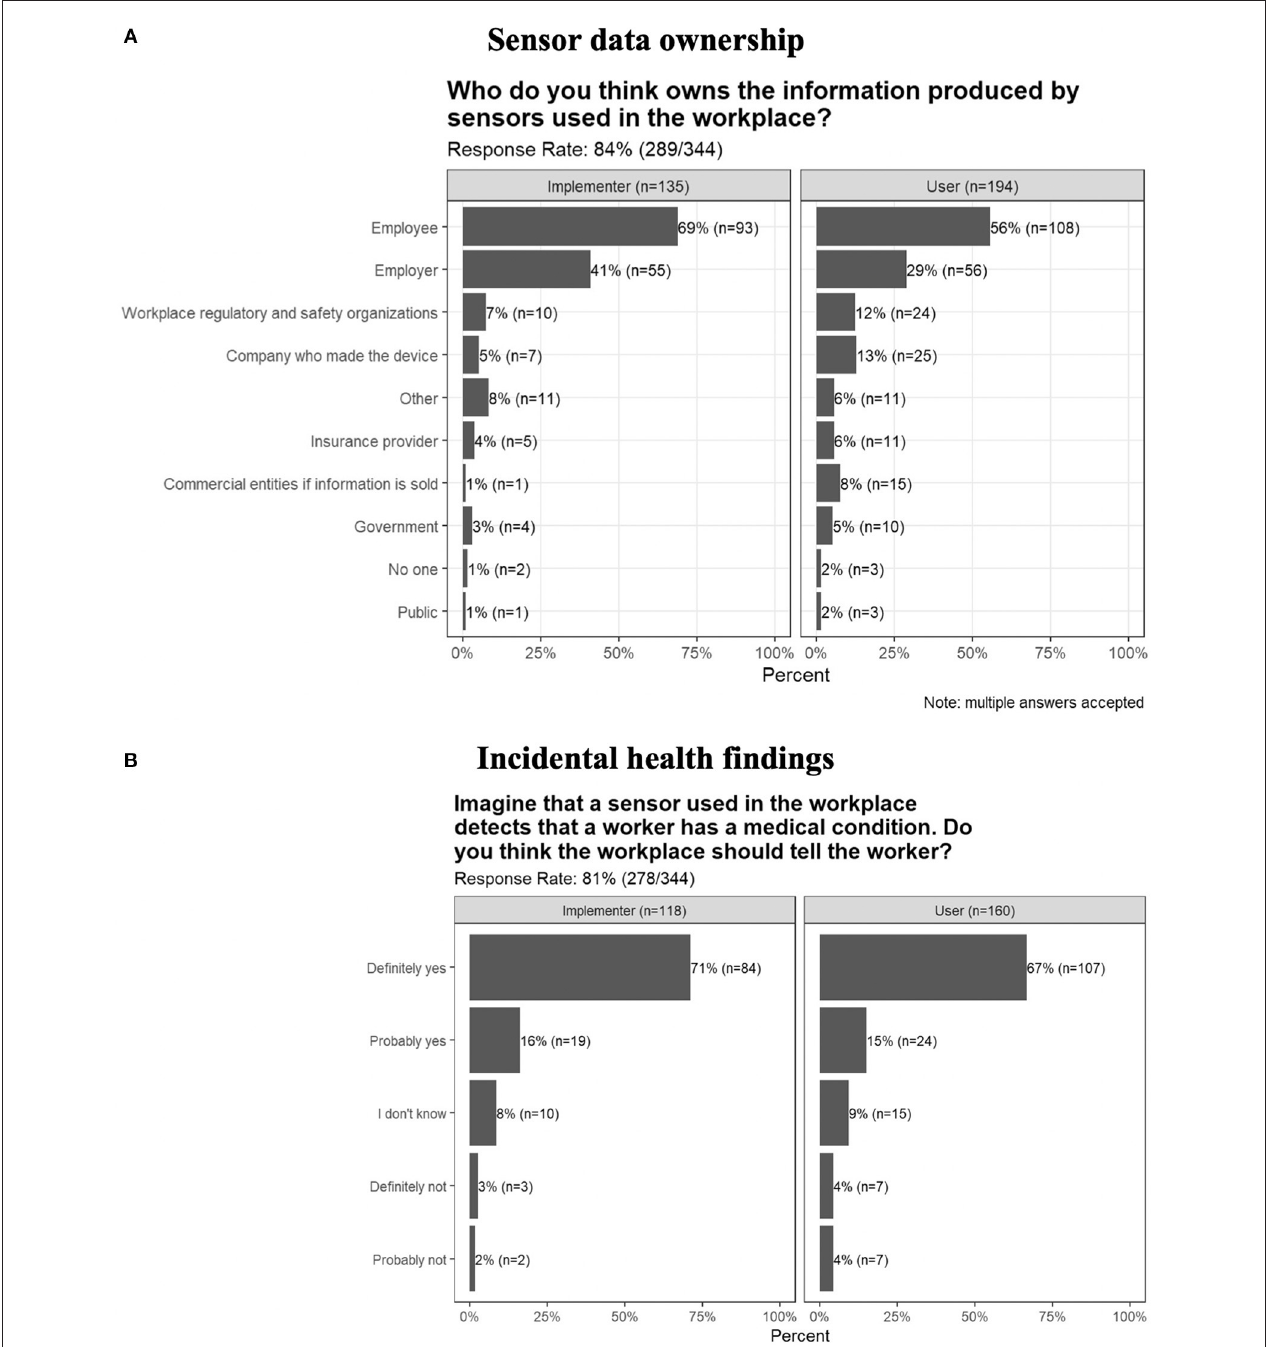
FIGURE 5 | Opinions on (A) the sharing of incidental health findings, and (B) sensor data ownership by Users and